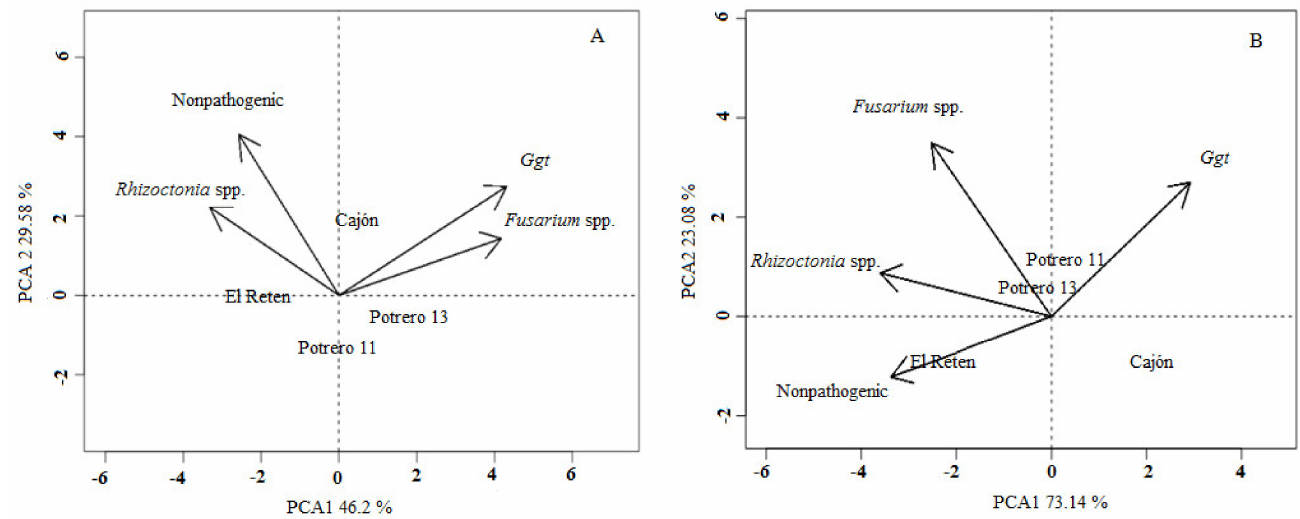
Figure 4. Principal components analyses for frequency of fungi present in four intensively sampled field in southern Chile during the grain-filling period. Relationships obtained for fungal populations in sites that presented negative bacterial populations ( A ) and positive populations with phlD ( B